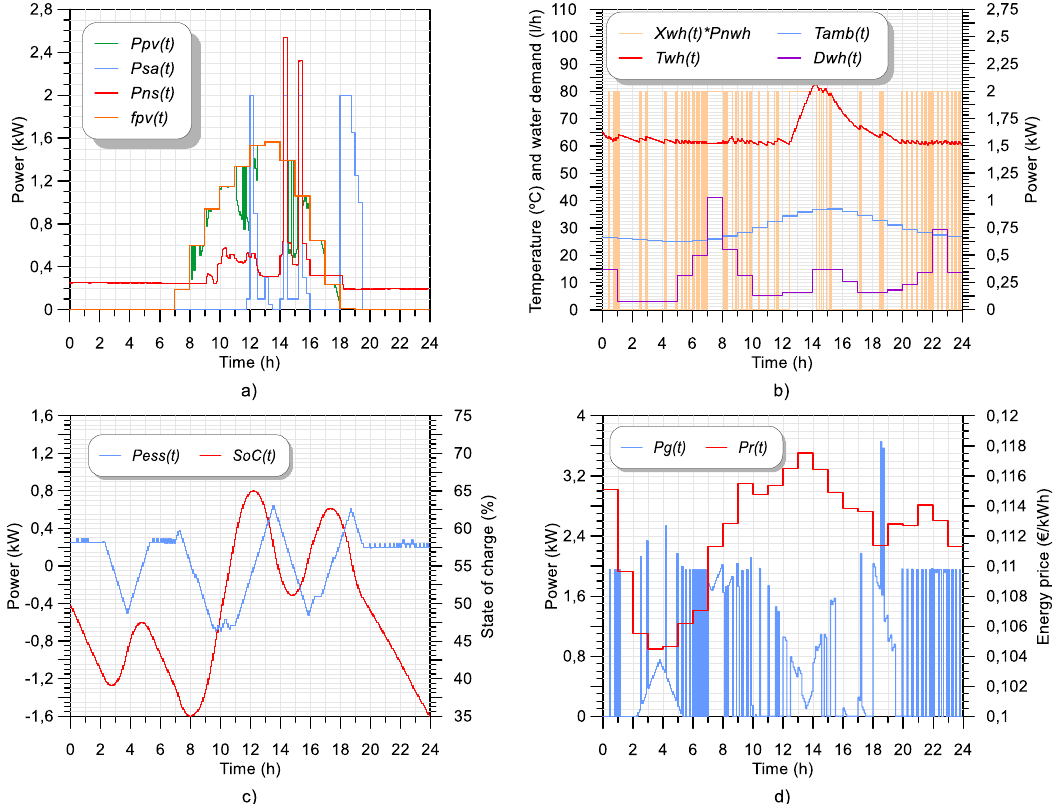
Figure 5. Optimization results using tariff A: ( a ) Power injected by the photovoltaic (PV) system, SA consumption, non-shiftable consumption, and PV production, ( b ) EWH performance: Consumption, ambient and water temperature as well as hot water demand, ( c ) energy storage system (ESS) performance: Power and state of charge (SoC), and ( d ) total consumption from the utility and energy prices.